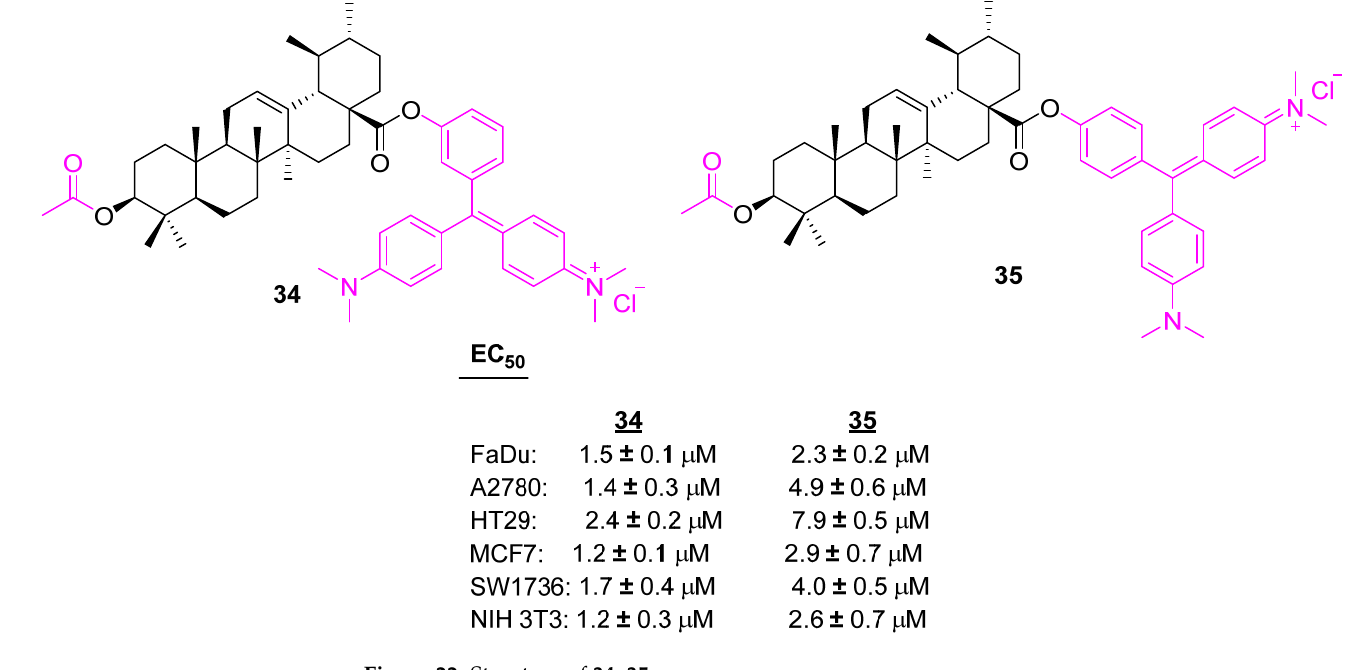
Figure 22. Structure of 34 , 35 .